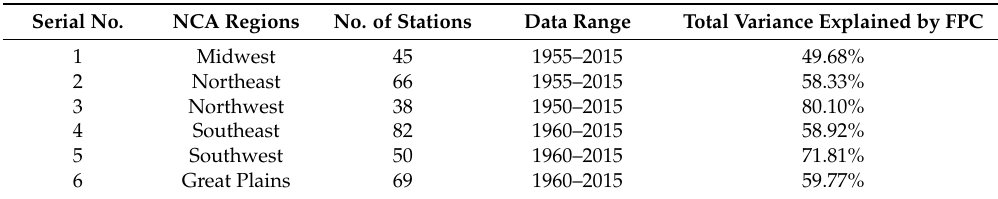
Table 2. The number of stations, data range, and the total percentage of variance explained by the first principal component (FPC) in each of the NCA